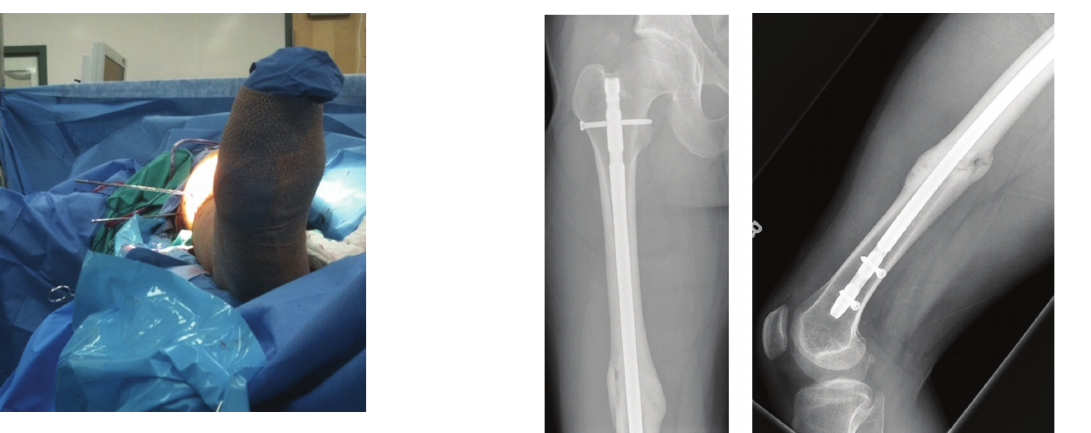
Figure 3: Axial cuts through femoral neck and condyles. Modified Jeanmart technique revealed 15 ∘ of external rotation of the right femur relative to the unaffected left femur.